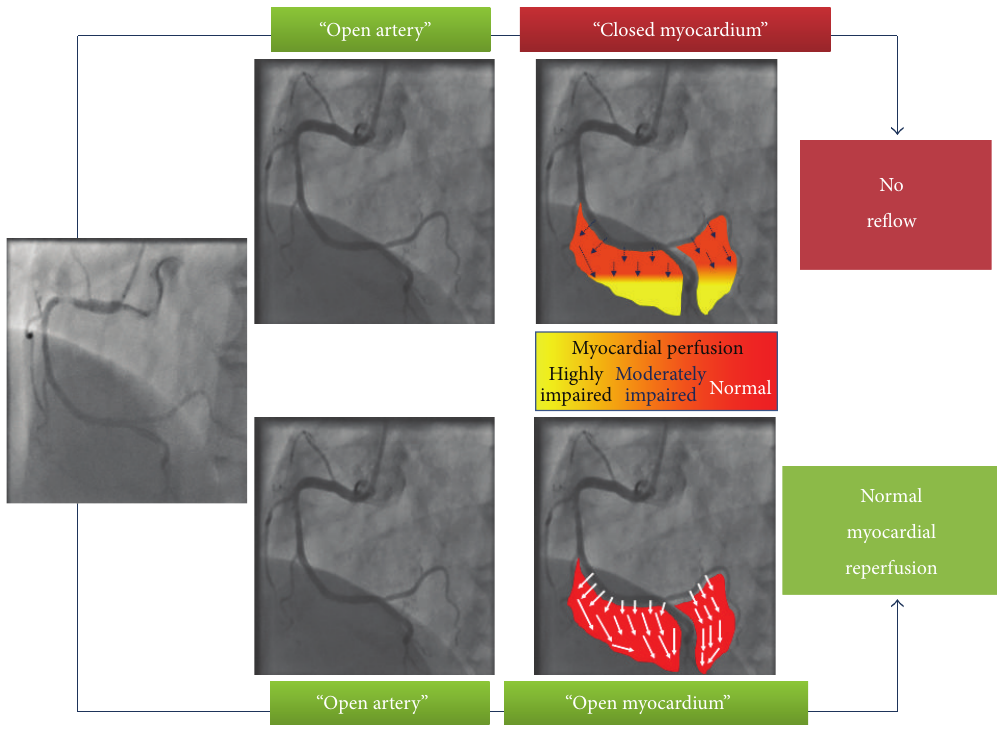
Figure 1: No reflow versus normal myocardial perfusion after